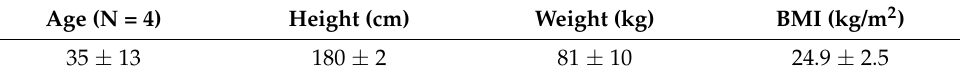
Table 4. Participants’ average physiology.